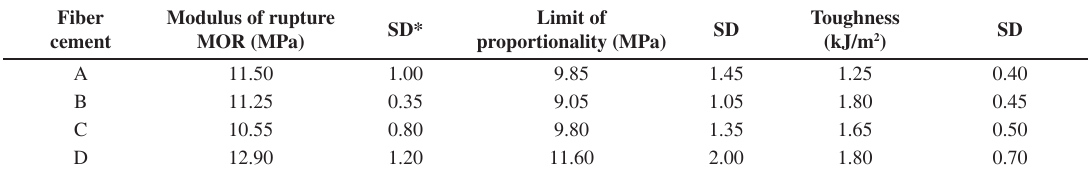
Table 11. Mechanical properties after soak & dry cycles. Fiber cement